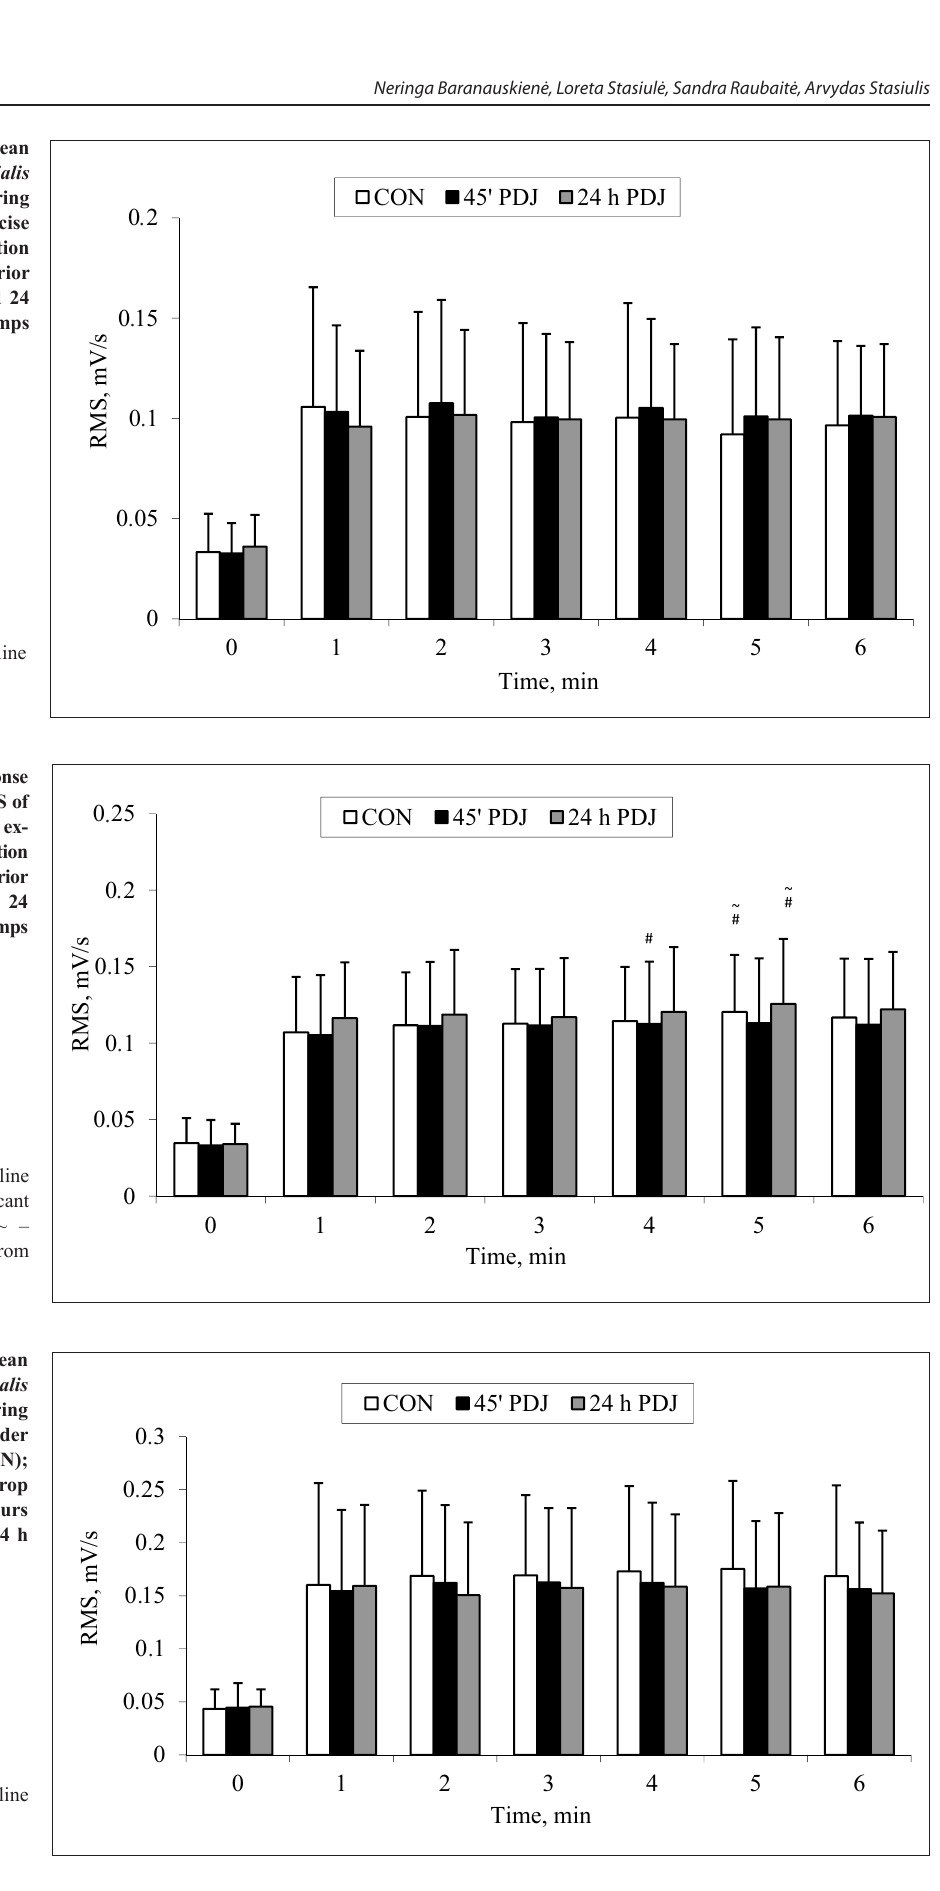
Note. 0 represents base line (20 W) cycling . Figure 4. Group mean response of m. vastus medialis in RMS of sEMG during heavy cycling exercise under control condition (CON); 45 minutes after prior drop jumps (45’PDJ) and 24 hours after prior drop jumps (24 h PDJ)